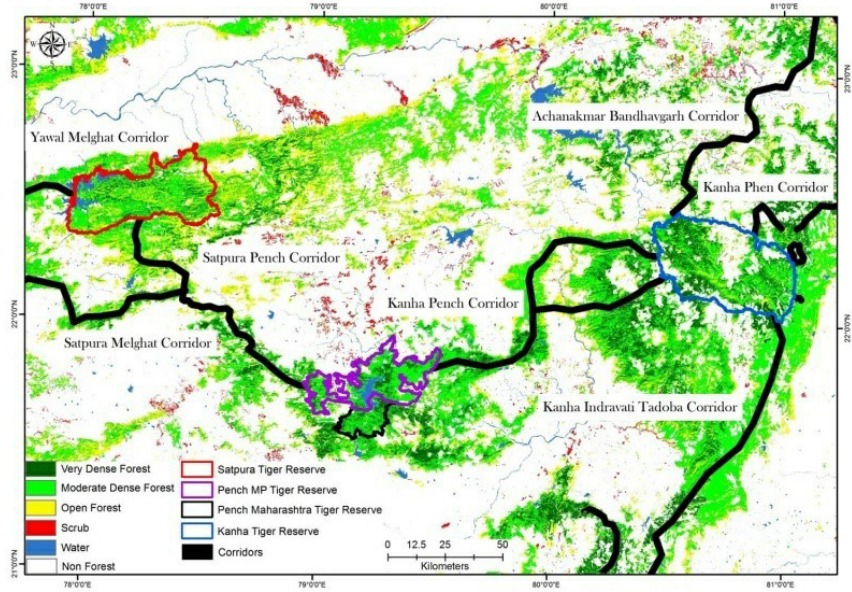
Figure A1. Location of Pench Tiger Reserve, Madhya Pradesh, in the central Indian tiger landscape along with its corridors with the surrounding protected areas (PAs). This map is reproduced from a study on connecting tiger populations for long-term conservation (Qureshi et al., 2014).